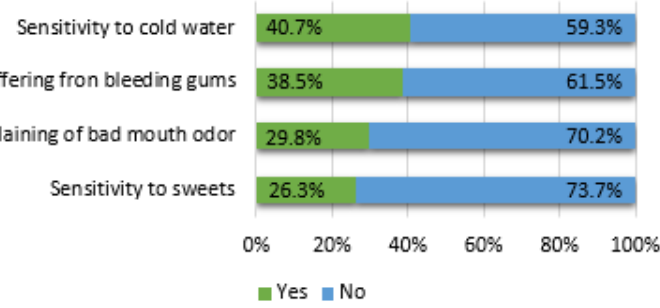
Figure 2. Dental and periodontal conditions.